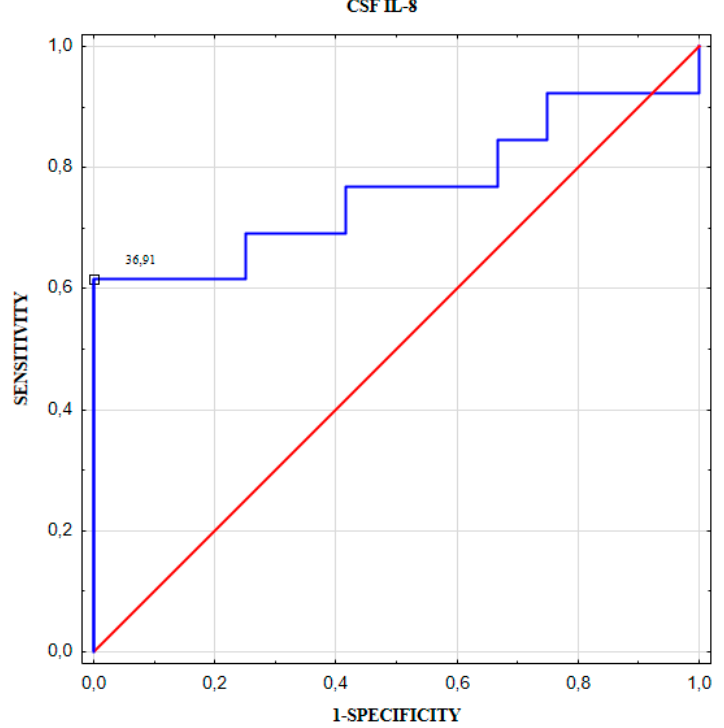
Figure 6. CSF IL-8 receiver operator characteristic (ROC) curve for predicting a larger brain aneurysm size ( ≥ 5.4 mm).